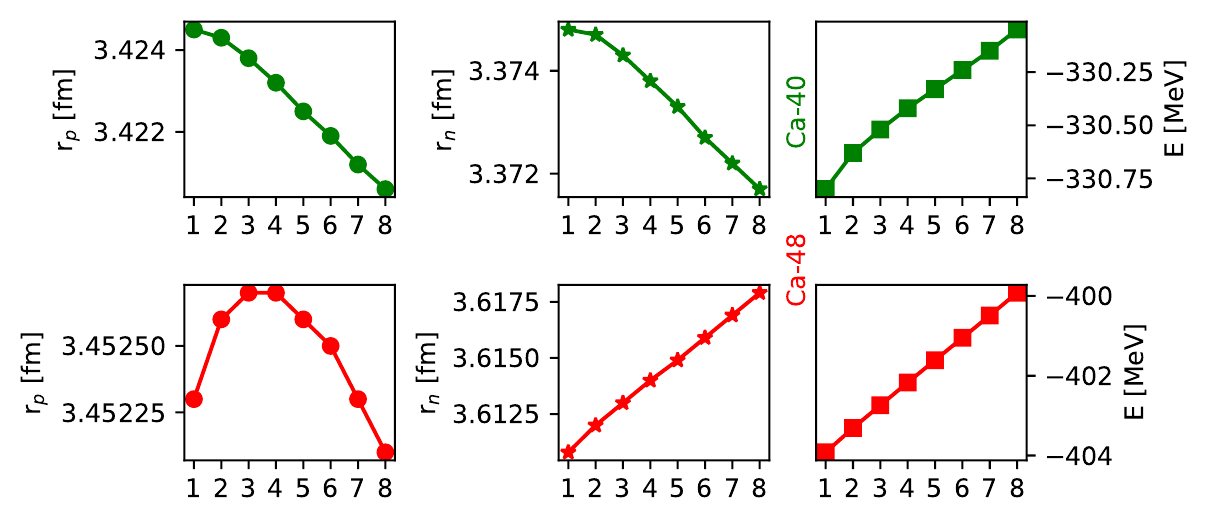
Figure 3. Ground state properties for 40 Ca (top row) and 48 Ca (bottom row) using the di ff erent SLy5s n forces for n = 1 .. 8. The observables are proton radius (left column), neutron radius (middle column) and energy (right column).